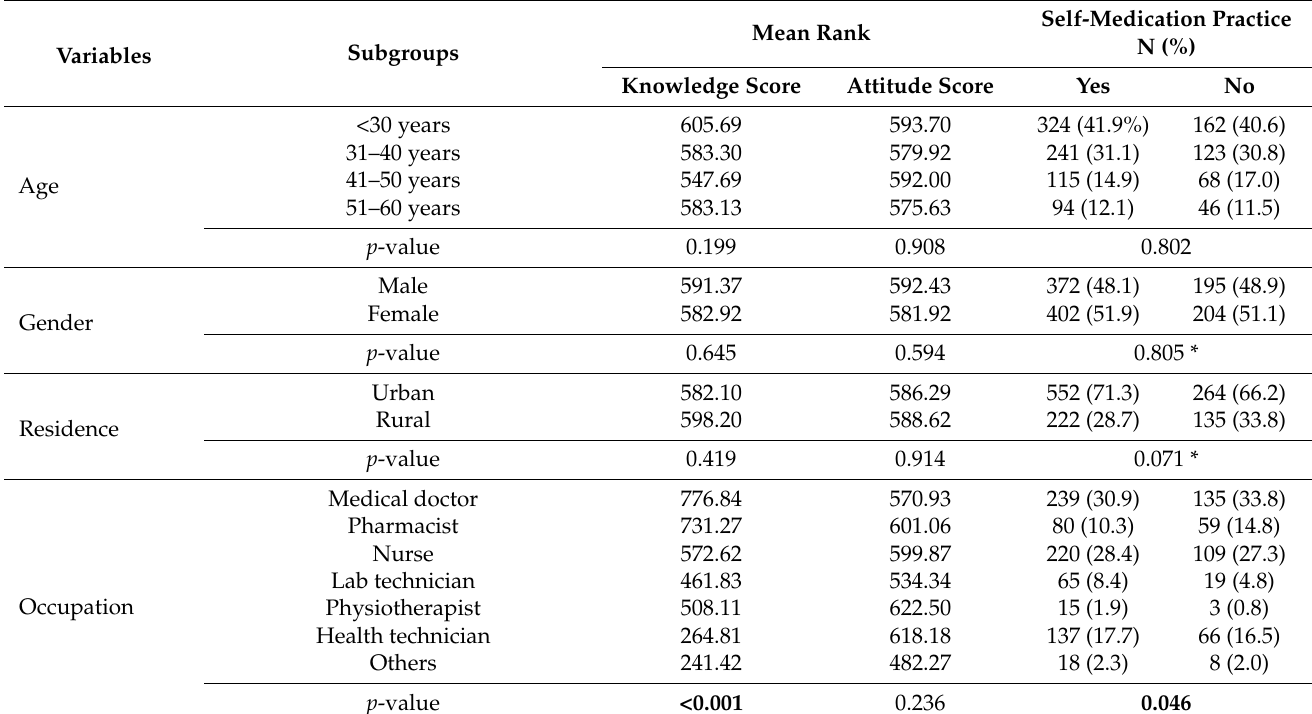
Table 2. Comparison of self-medication-related knowledge and attitude scores among selected demographics.